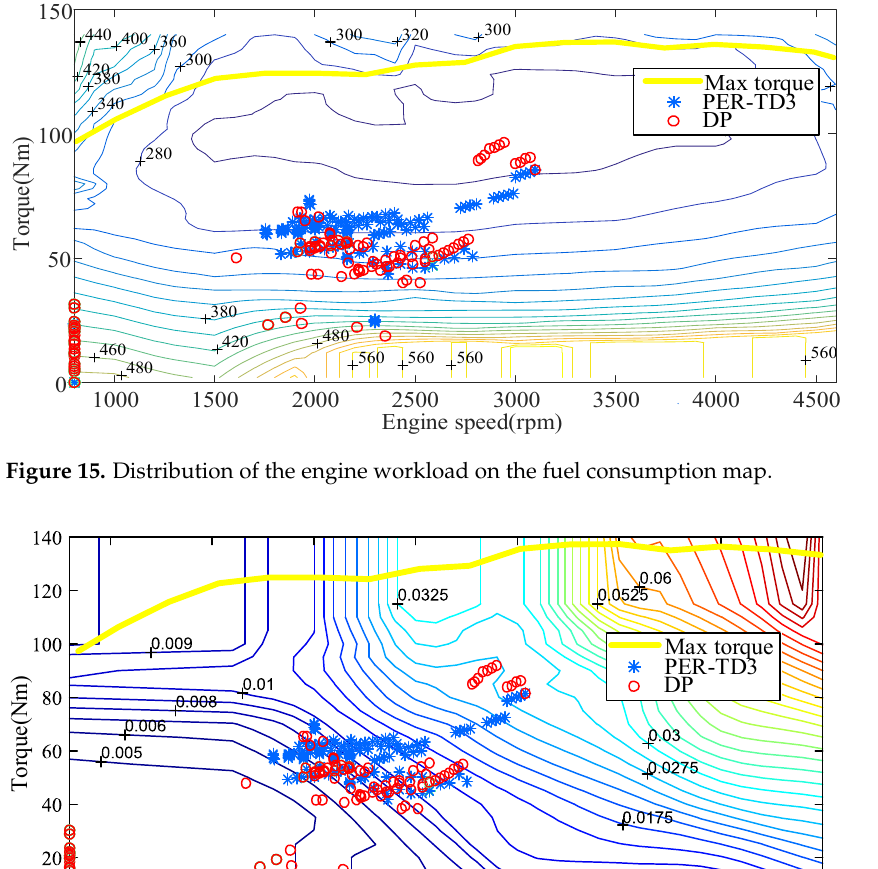
TD3 DPPER-TD3 Figure 14 . SCR catalytic efficiency of different strategies. Figures 15 and 16 illustrate the distribution of the engine workload on the fuel con ‐ sumption and NO X emissions map. It can be seen that the engine workload is nearly con ‐ strained in the medium load region. In other words, the average operation efficiency of the engine can be improved under this condition. At the same time, the workload distri ‐ bution of the PER ‐ TD3 ‐ based control strategy is close to that of the DP ‐ based strategy, which realizes the optimal policy behavior. The results of the PER ‐ TD3 ‐ based, TD3 ‐ based, DDPG ‐ based, and DP ‐ based control strategies are listed in Table 3. The engine fuel con ‐ sumption and NO x emissions are 2.477 L/100 km and 0.2008 g/km, nearly 94.1% and 90.1% of those of the DP ‐ based control strategy. By contrast, the fuel consumption and NO x of the DDPG ‐ based and the TD3 ‐ based control strategy are 2.557, 0.2078, 2.509, and 0.2023,